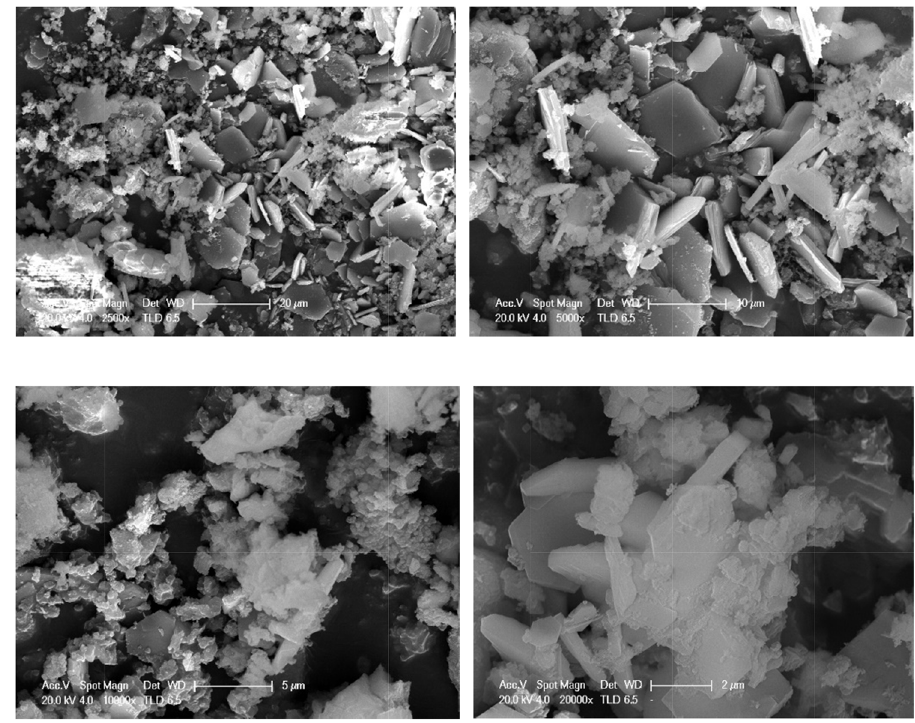
Figure 6: SEM photograph of the products in the crack area.